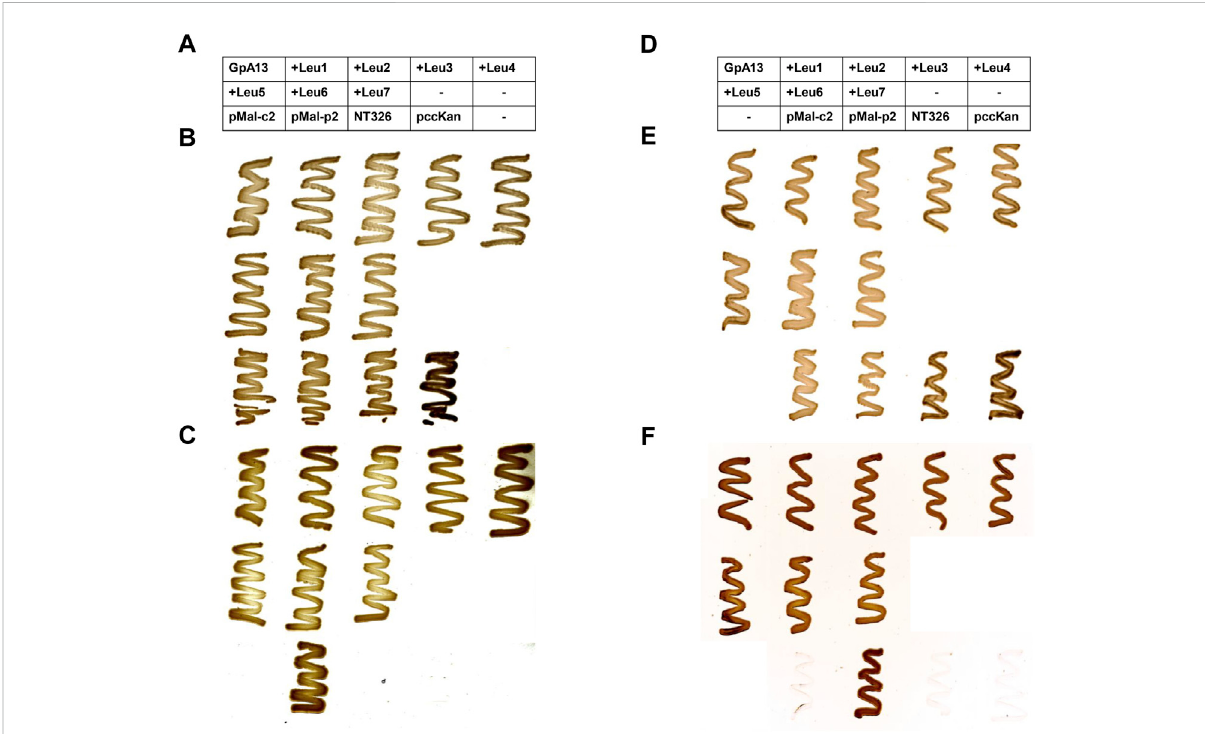
FIGURE 2 malE complementation assay. In order to test the orientation of the ToxR (TM) MalE chimeric proteins, MalE-de fi cient E. coli NT326 cells were transformedwithplasmidsencodingthechimericproteinsandcultivatedonM9minimalmediumsupplementedwitheitherglucose (B,E) ormaltose (C,F) .MalE-de fi cientcellscangrowonmaltoseasthesolecarbohydratesourceexclusivelywhentheMalEdomainoftheexpressedchimericprotein islocatedwithinthe E.coli periplasm.Incontrast,whenglucoseisofferedasacarbohydratesource,allcellsareexpectedtogrow.Cytoplasmic MalE expression from the plasmid pMal-c2, as well as the MalE-de fi cient strain NT326, and NT326 cells transformed with the pccKan plasmid used for cloning and construction of GpA TM helix-expressing chimeric proteins served as negative controls. These cells should not grow on maltose- containing medium. In contrast, periplasmic MalE expression from the plasmid pMal-p2 was expected to complement for the malE de fi ciency of NT326 cells, and thus serves as a positive control. Expression of all chimeric proteins resulted in complementation of the NT326 growth defect on maltose-containing medium, and thus all encoded proteins were expressed with the correct TM topology, i.e., the MalE domain located within the E.coli periplasm. (A – C) :GpAwt; (D,E) :GpAG83I.Thetablesin (A,D) describethelocationof E.coli NT326celltransformedwitharespectiveplasmid on the plate. When columns of the table are empty (marked with an “ − ” ), no cells were streaked out on the respective positions on the